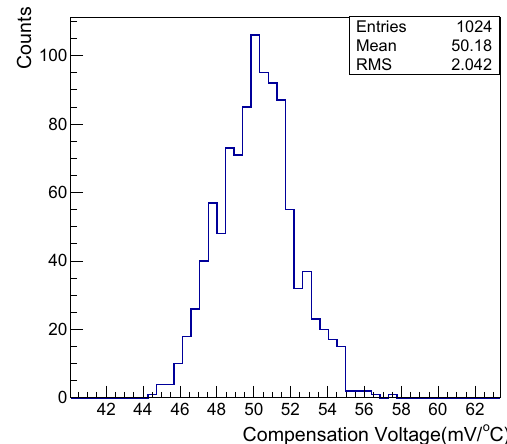
Fig. 6 Distribution of the compensation voltage of 1024 pixels in the first camera The data acquisition (DAQ) program reads the voltage and temperature of the SiPMs every 30 seconds. If the tempera- ture variation of the pixel exceeds ± 1 ◦ C, the compensated V bias is calculated according to its characteristic and the mea- sured temperature. Then the supply voltage is updated to the calculated